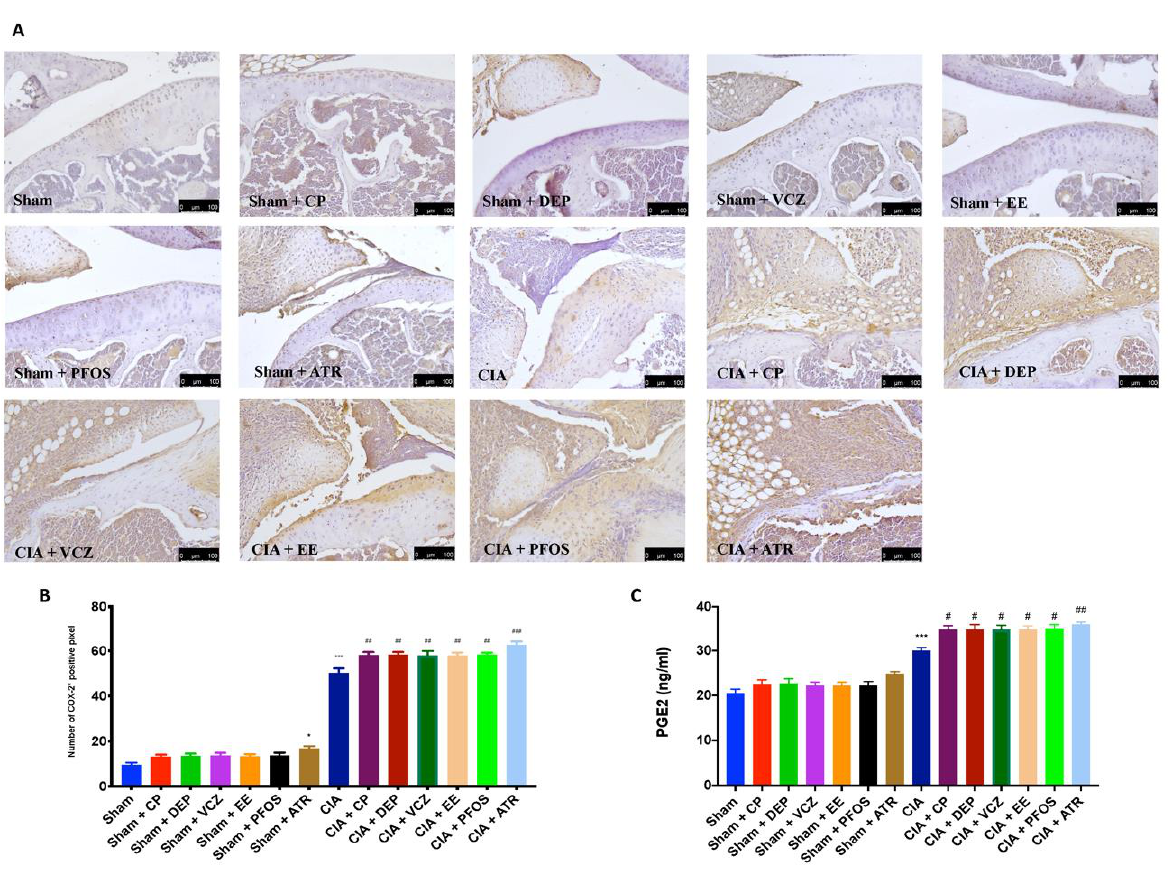
Figure 10. Immunohistochemical evaluation in knee joint for COX-2 expression ( A ); graphical quantification of COX-2 expression ( B ); levels of PGE2 in plasma ( C ). A 20X magnification is shown (100 µm scale bar). * p < 0.05 vs. sham; *** p < 0.001 vs. sham; # p < 0.05 vs. CIA; ## p < 0.01 vs. CIA; ### p < 0.001 vs. CIA.